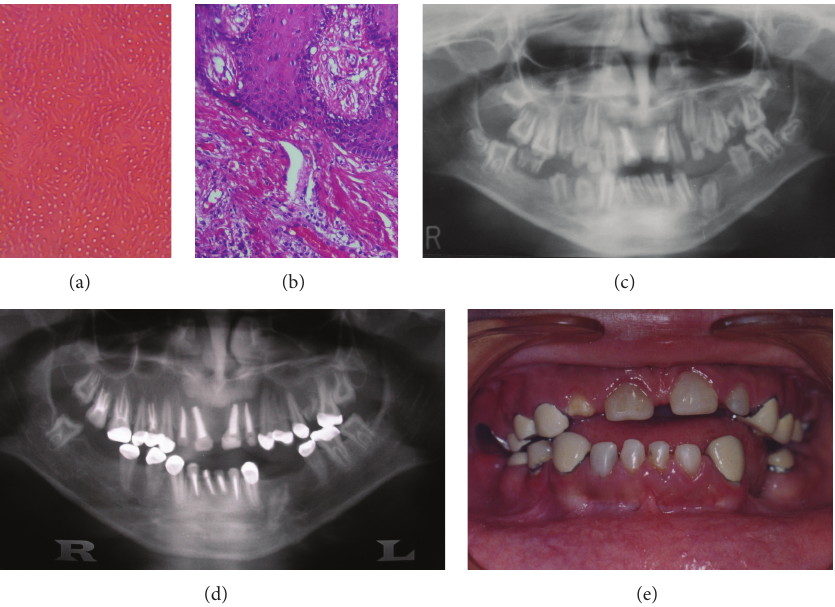
Figure 2: (a) Histological examination showing dentin having torturous dentinal tubules and globular masses of dentine interrupting them (original magnification 20x). (b) Gingival biopsy examination showing odontogenic tissue in the epithelium and intramesenchymal calcifications (original magnification 20x). (c) Panoramic view showing apexification trial. (d) RCT without crowning was done for incisors and upper-right second molar. RCT with crowning was performed for upper-right second premolar and first molar and upper-left first premolar. Crowning without RCT was done for the vital upper-left premolars, left second molar, lower left second premolar, lower left second molar, lower canines, right first premolar, and upper-right first molar. (e) Final oral condition at 18 years of